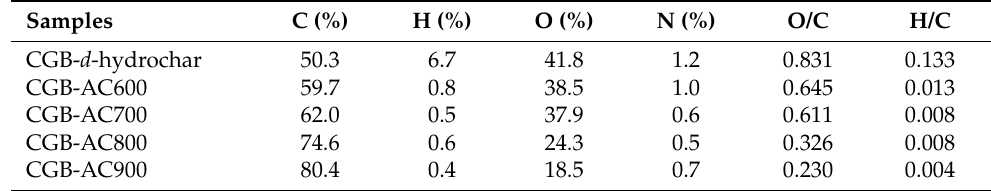
Table 1. Elemental analysis of the CGB- d -hydrochar and CGB-AC